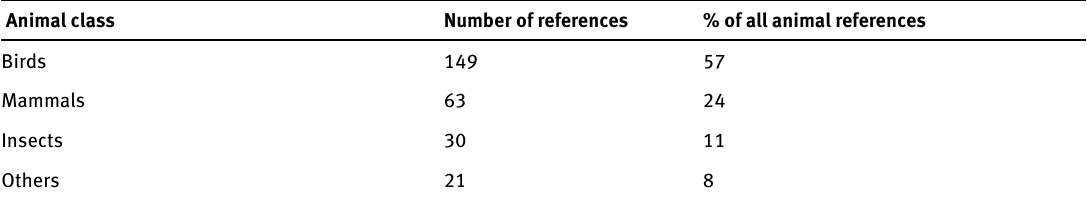
Table 3. The animal classes referred to in the